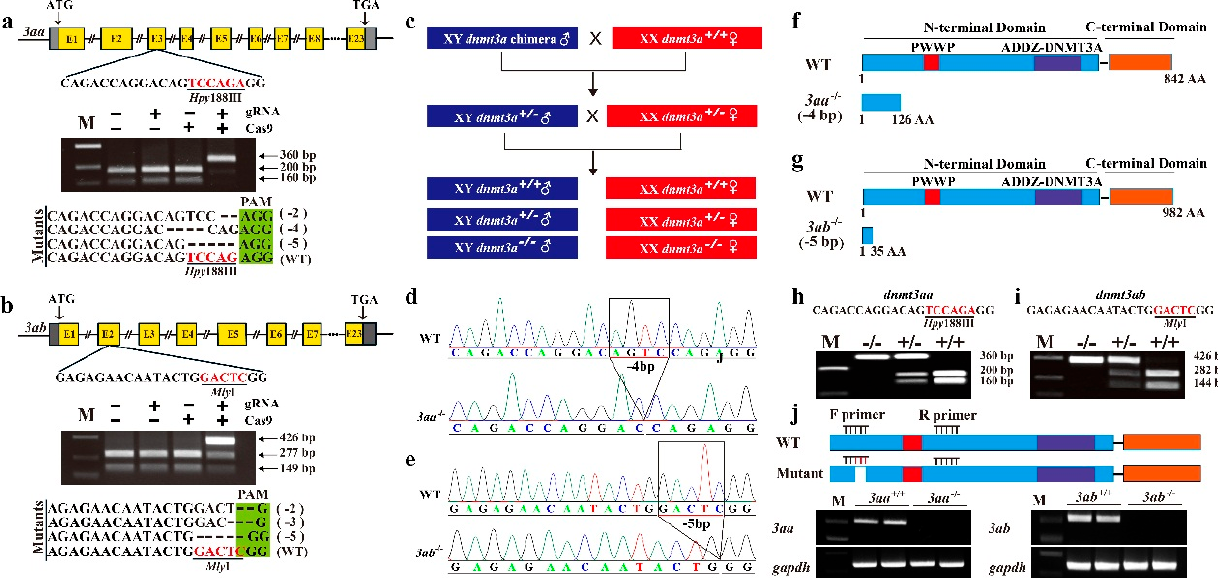
Figure 2. Establishment of dnmt3aa and dnmt3ab mutant lines. ( a , b ) Gene structure of dnmt3aa and dnmt3ab showing the target site and the Hpy 188III and Mly I restriction site. The Cas9 mRNA and gRNA were added as indicated. Sanger sequencing results from the uncleaved bands are listed. The PAM is marked in light green. Deletions are marked by dashes (-) and numbers to the right of the sequences in parentheses indicate the loss of bases for each allele. The mutant fish that carried 4 and 5 base-pair deletions were used for homozygous mutant construction of dnmt3aa and dnmt3ab , respectively. WT, wild type. ( c ) Schematic diagram showing the breeding plans of dnmt3aa and dnmt3ab F0 to F2 fish. ( d , e ) Sequencing results of dnmt3aa and dnmt3ab genes from WT and homozygous mutant fish. ( f , g ) Schematic diagram of Dnmt3aa and Dnmt3ab wild type (WT) and the predicted truncated protein. ( h , i ) Identification of F2 genotypes by restriction enzyme digestion assay. ( j ) RT-PCR analysis of dnmt3aa and dnmt3ab mRNA expression in gonads of mutants and WT fish. The 3 ′ sequences of forward primer were designed on the target site, which is indicated by white box. No band was amplified in the homozygous mutants, while one band corresponding to dnmt3aa and dnmt3ab mRNA was amplified in the WT XY testes. gapdh was used as internal control.